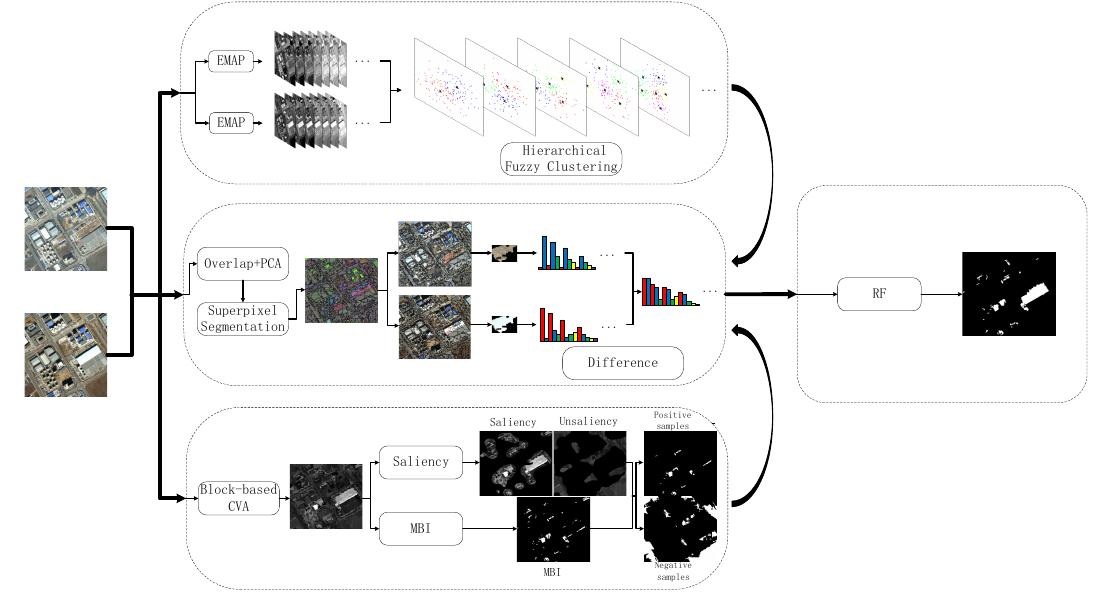
Figure 1. Flowchart of the proposed method. EMAP, extended morphological attribute profile; CVA, change vector analysis; MBI, morphological building